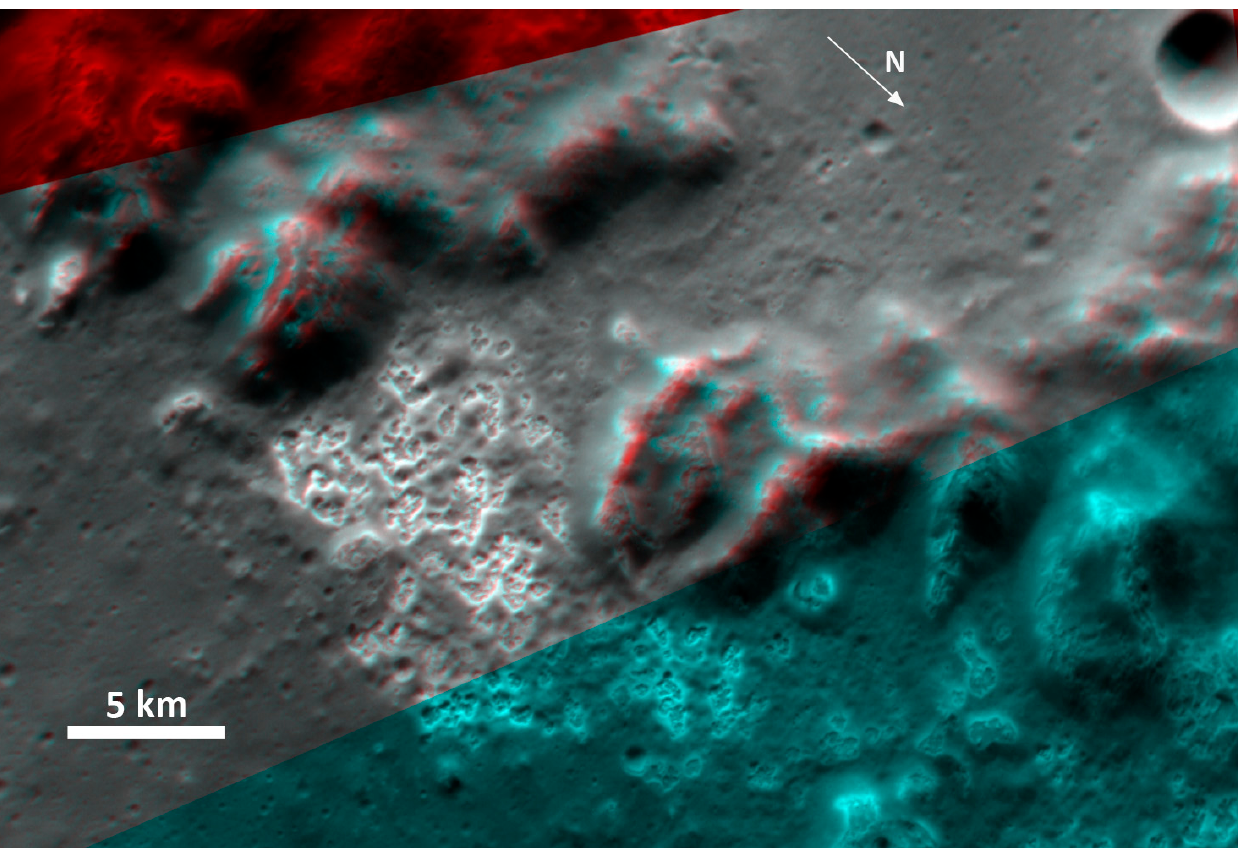
Figure A11. Sander Crater. Images: EN0218289182M, EN0217906385M.